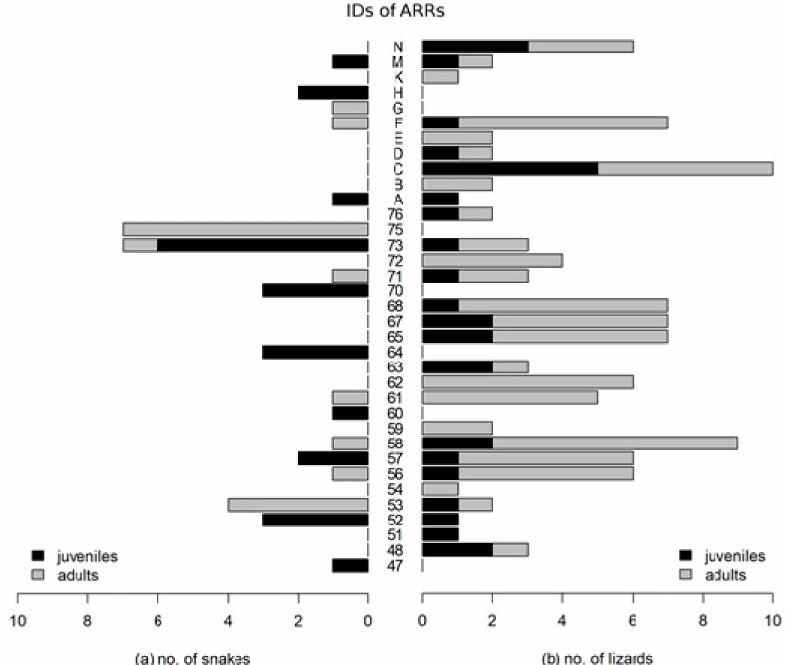
Figure 2. Comparison of the number of adults and juvenile specimens under particular occupied shelters (the IDs according to Figure